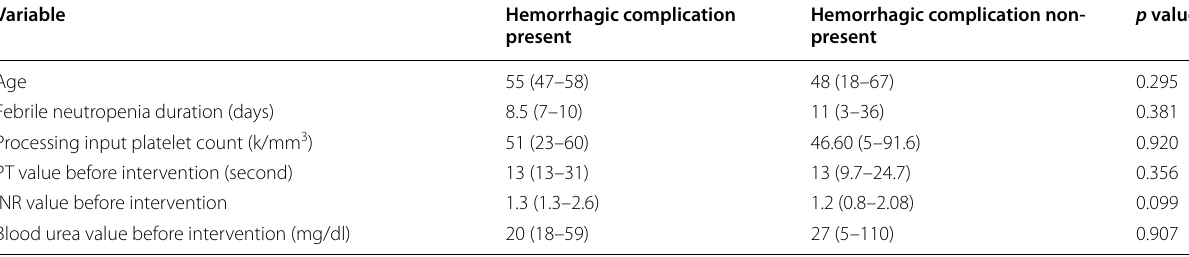
Table 2 Comparison of various groups in terms of hemorrhagic